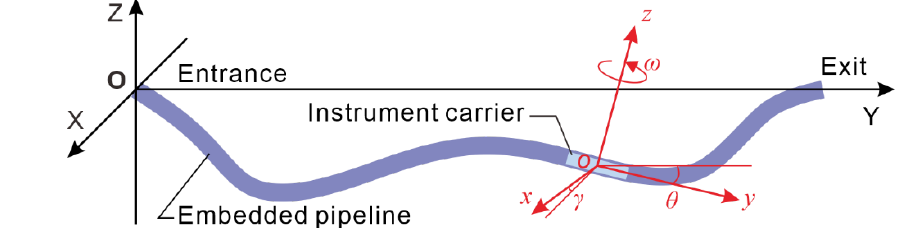
Figure 6. Block diagram of measuring system circuit.